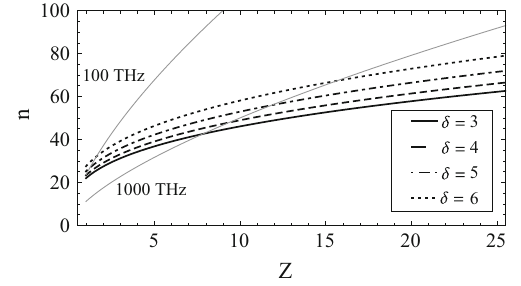
Fig. 1 In transitions between Rydberg states of muonic Hydrogen- like ions below the dashed lines, the influence of hidden dimensions, through the classical higher-dimensional gravity, can be greater than promised experimental uncertainty in measurements of transition fre- quencies around the optical band (100–1000 THz). Here we are assum- ing that G D /σ δ − 2 has the appropriate value to solve the proton radius puzzle